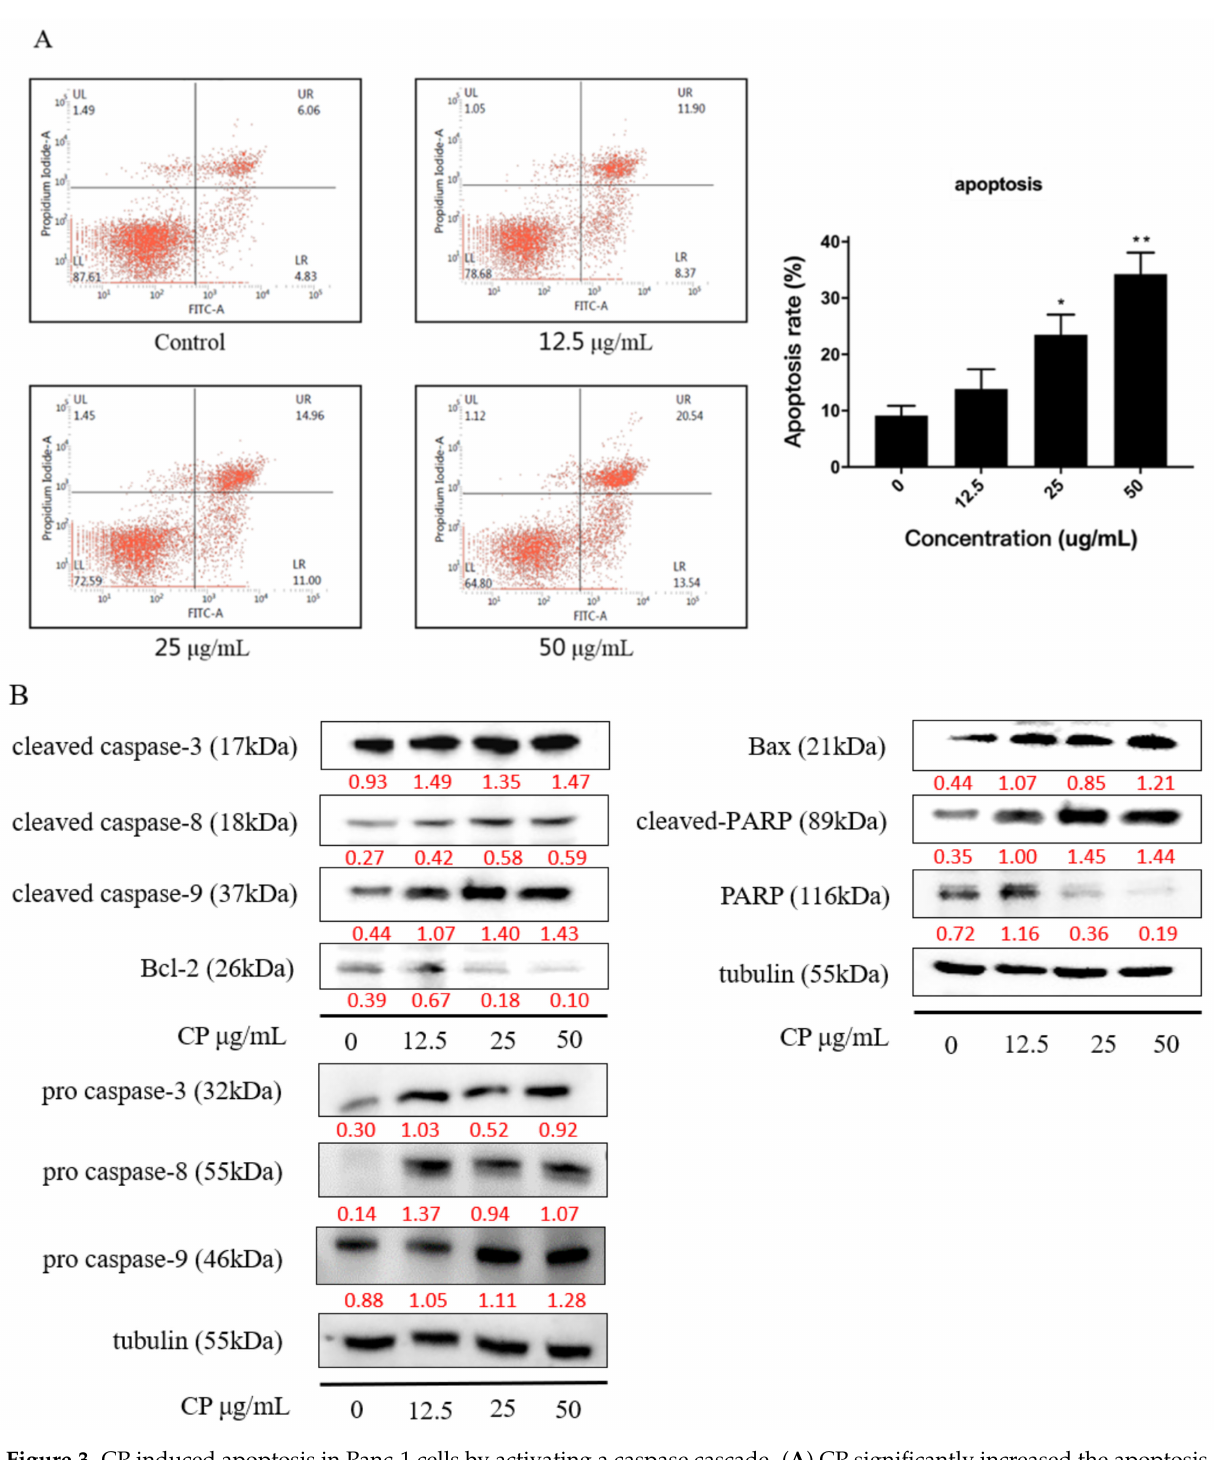
Figure 3. CP induced apoptosis in Panc-1 cells by activating a caspase cascade. ( A ) CP significantly increased the apoptosis rate of Panc-1 cells in a dose-dependent manner. ( B ) Caspase cascade was activated after CP treatment; the expression of the caspase family of proteins was analyzed by Western blot. Data are presented as mean ± SD; * p < 0.05 and ** p < 0.01 versus control; n =